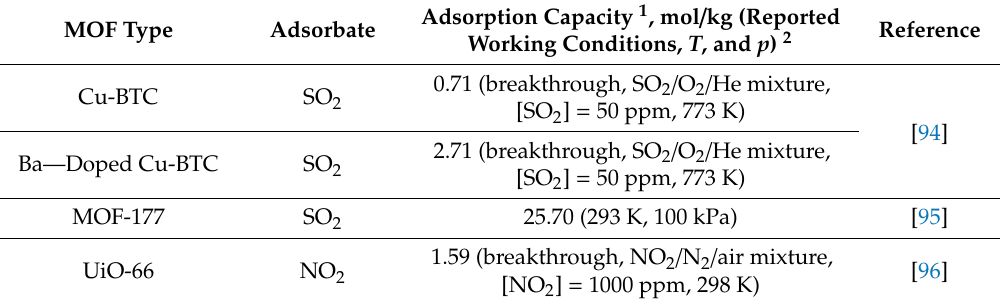
Table 3. MOFs potentially suitable for SO x and NO x